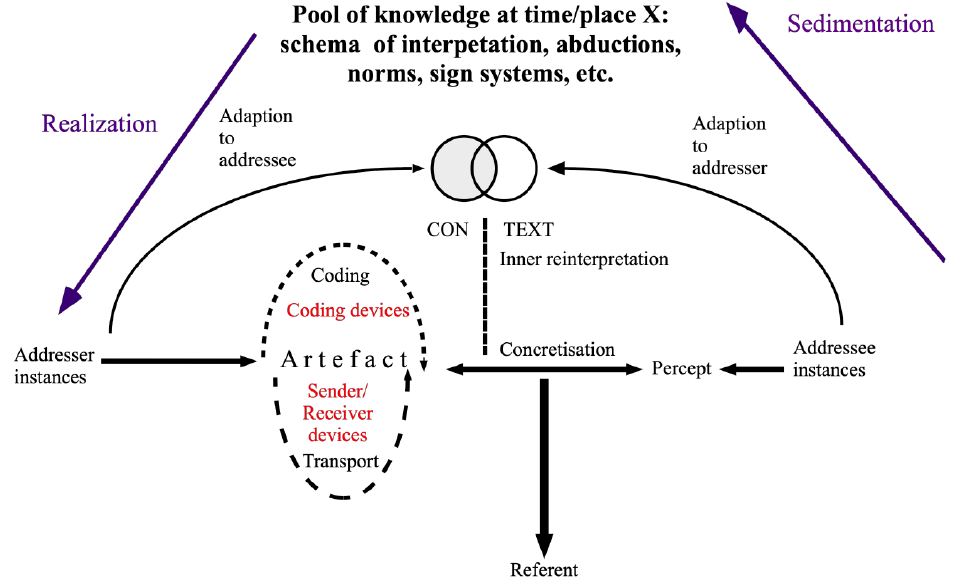
Figure 2. The act of communication, as construed in Sonesson [48,77], with the addition of the process of sedimentation, which is the accumulated memory of historicized acts, and the process of realization, which recovers the structure of the act from the pool of knowledge which is sedimented. Mutatis mutandis , this dialectic between sedimentation and realization is valid for any act, as well as non-communicative ones. The figure is reproduced here to put emphasis on such a dialectic of realization and sedimentation. For other details of the figure, see Sonesson [48,77].